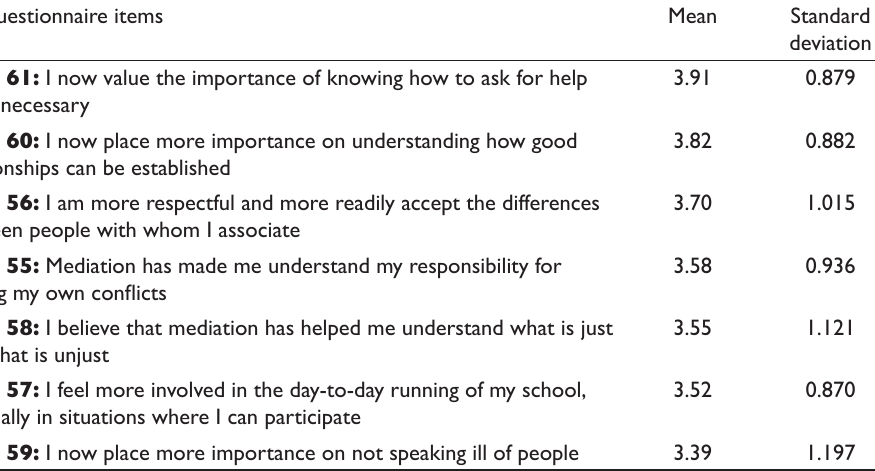
Table 4: Means and standard deviations on socio-moral aspects found among peer-mediators